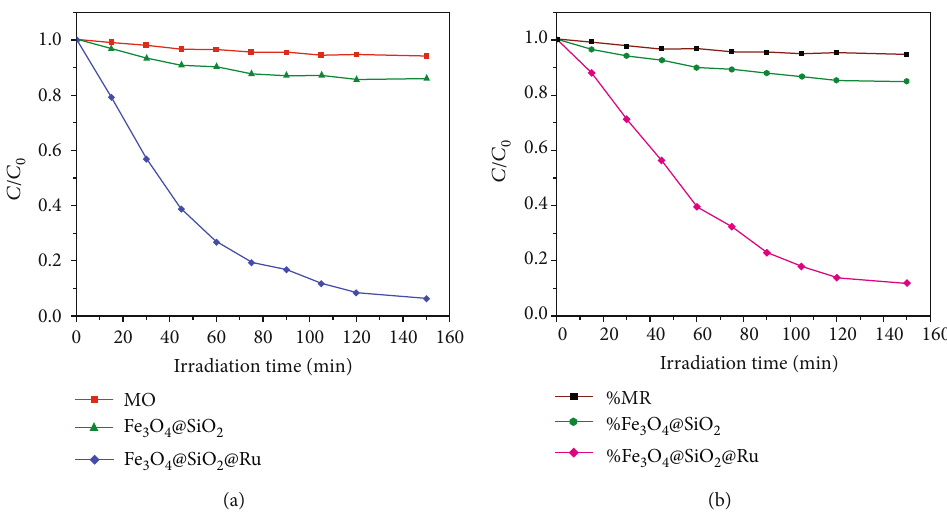
Figure 10: Photocatalytic degradation of (a) MO and (b) MR by Fe